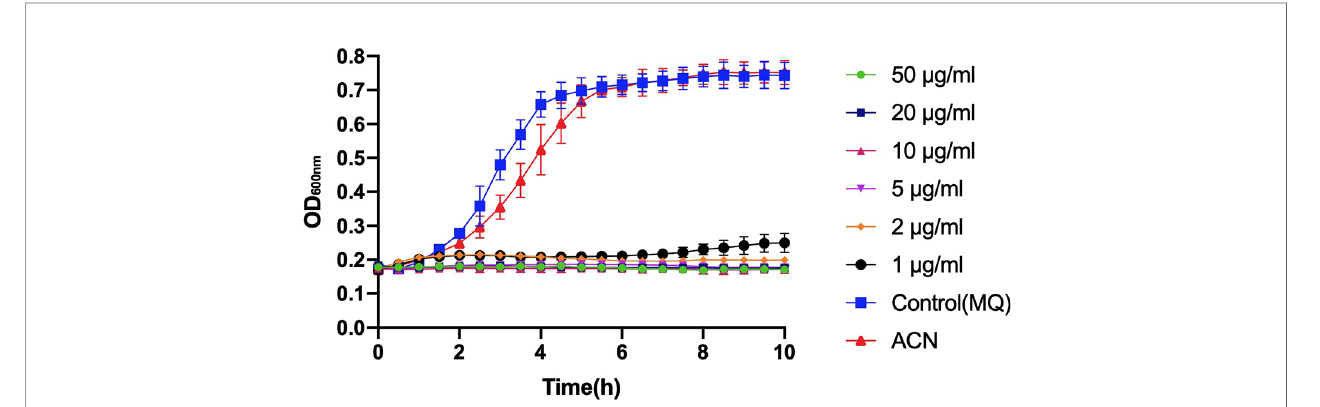
FIGURE 2 | Growth curve of planktonic Streptococcus mutans UA159 incubated with 1, 2, 5, 10, 20, and 50 µg/ml of 1,3-bis[3,5-bis(tri fl uoromethyl)phenyl]urea (BPU). The same volumes of deionized water (MQ) and acetonitrile (ACN) were added to control groups. Values indicate means ± SDs from three independent